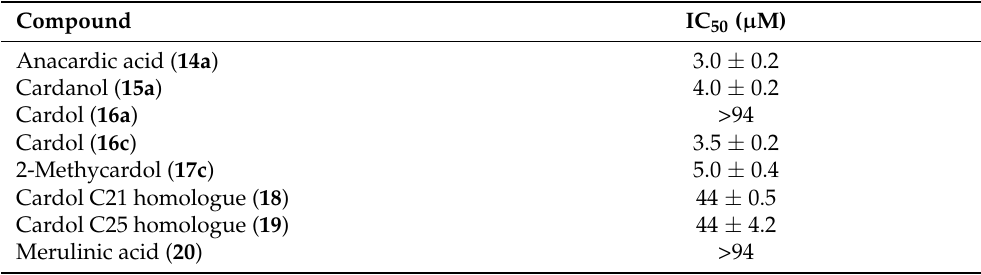
Table 2. AChE inhibition of phenolic lipids from A. occidentale , rye grain, and M. tremellosus